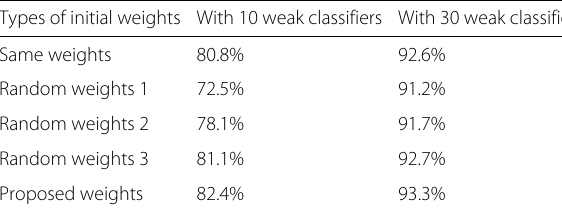
Table 4 Comparison of correct classification rates with differential initial weights